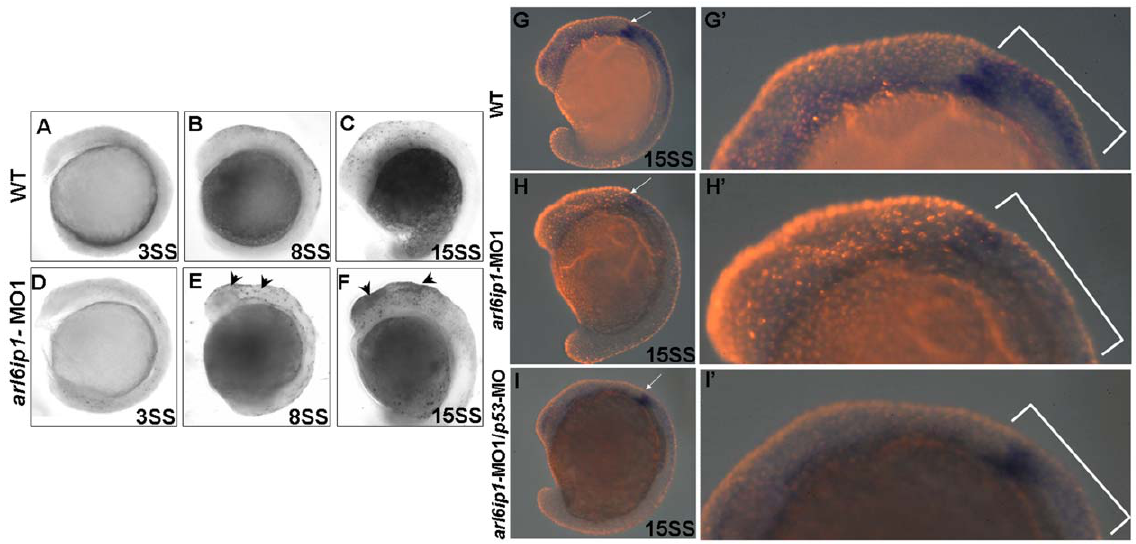
Figure 8. Cell death does not cause the loss of neural crest cells. Lateral views of TUNEL-labeled wild-type (WT) embryos (A–C) or arl6ip1 - MO1-injected embryos (D–F) at 3-somite stage (A, D), 8-somite stage (B, E), and 15-somite stage (C, F), respectively. (A, D) There were no TUNEL- positive cells in WT and arl6ip1 -MO1 embryos. (B, C, E, F) Compared to WT embryos, arl6ip -deficient embryos displayed a significant increase of TUNEL-positive cells in the dorsal region of embryos at the 8- and 15-somite stages (indicated by arrowheads) (B and C vs. E and F). (G, H, I) Double- labeling analysis with crestin (dark blue) and TUNEL (red fluorescent) showed that only limited cell death occurred at the expression region of crestin . (G 9 , H 9 , I 9 ) The views of the embryos shown in panels G 9 , H 9 and I 9 were at higher magnification.